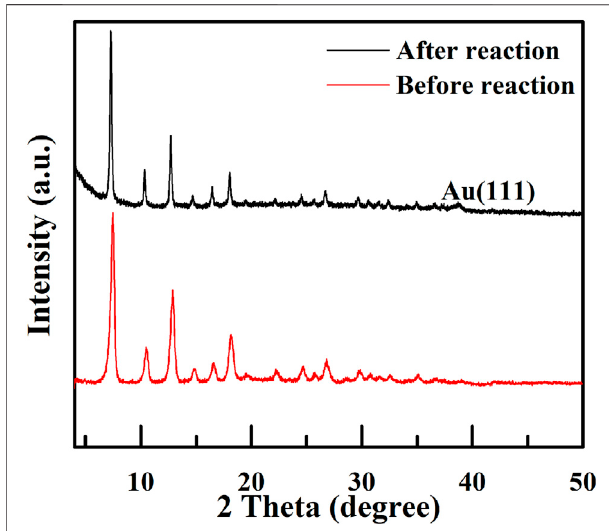
FIGURE 7 | XRD patterns of Void|(Au)ZIF-8|ZIF-8 before and after reaction for the one-pot cascade catalytic synthesis of imines from benzyl alcohol and